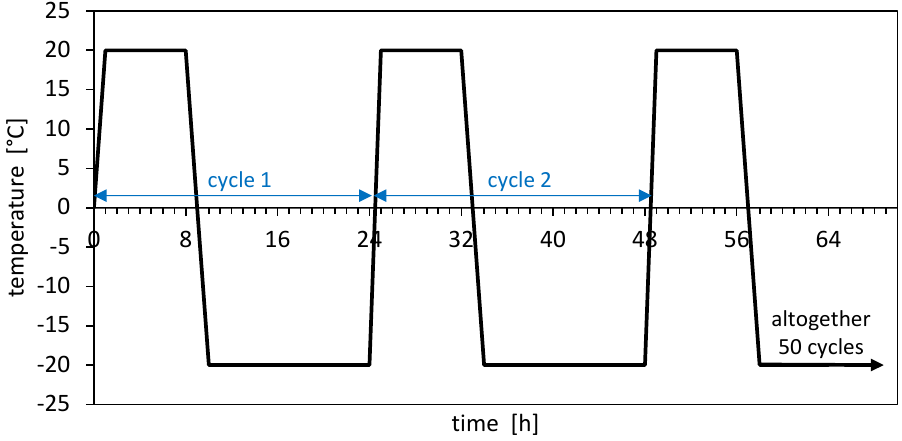
Figure 1. Schematic temperature cycles of freeze-thaw tests in accordance to the regulations provided in EAD 330499-01-0601, Section 2.2.2.7 [3].